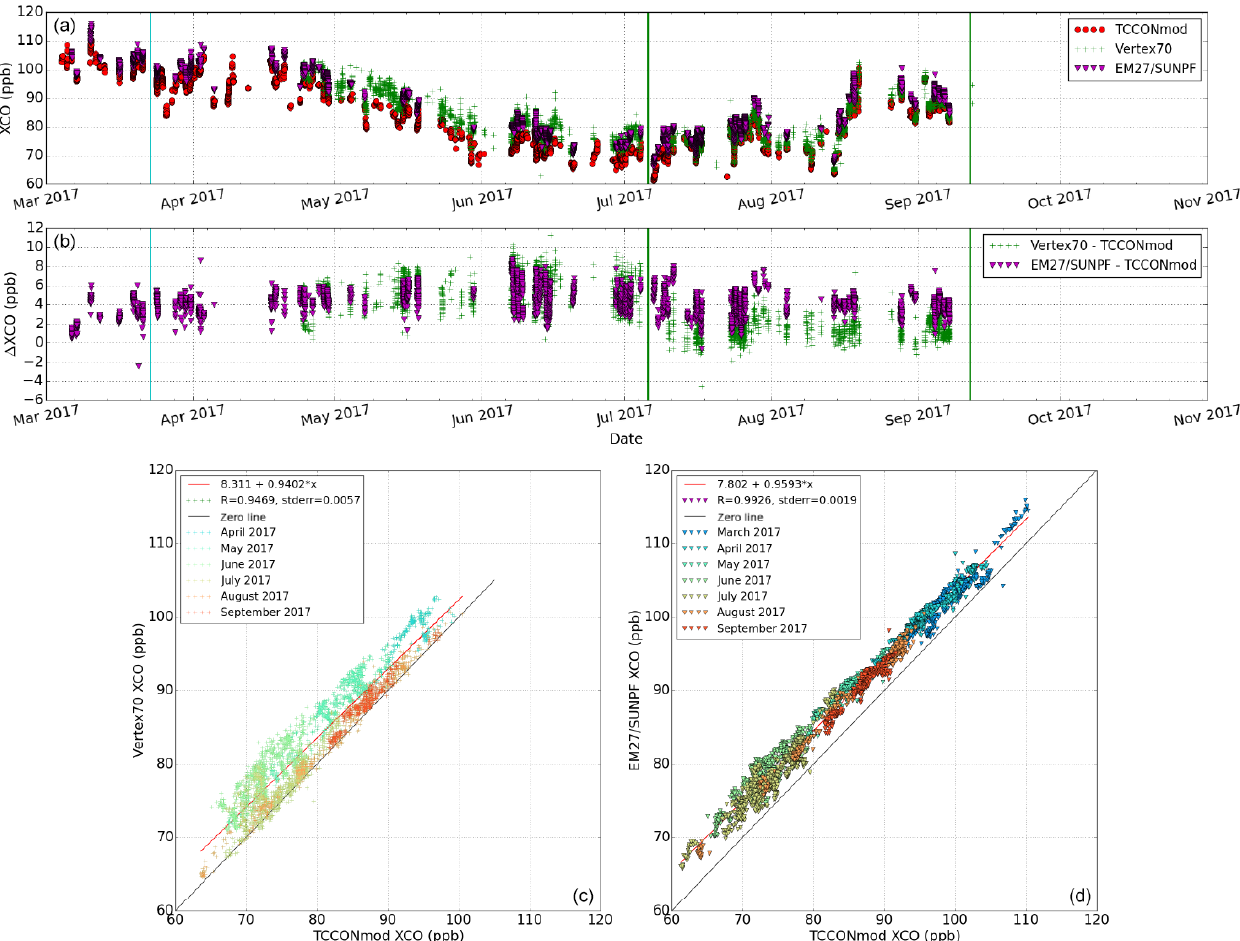
Figure 9. Time series of XCO retrievals for TCCONmod, Vertex70, and EM27/SUN using the standard procedure with the TCCON a priori for measurements performed at Sodankylä in 2017 (a) and the difference of XCO time series for each instrument relative to the reference TCCONmod results (b) . The correlation plots of XCO from Vertex70 and EM27/SUN instruments vs. TCCONmod for all measurements with SZA < 75 ◦ : (c) Vertex70 vs. TCCONmod; (d) EM27/SUN vs. TCCONmod. The colours represent the measurements performed during the different months of the